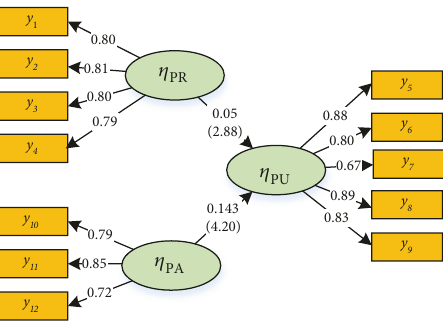
Figure 8: MIMIC submodel for